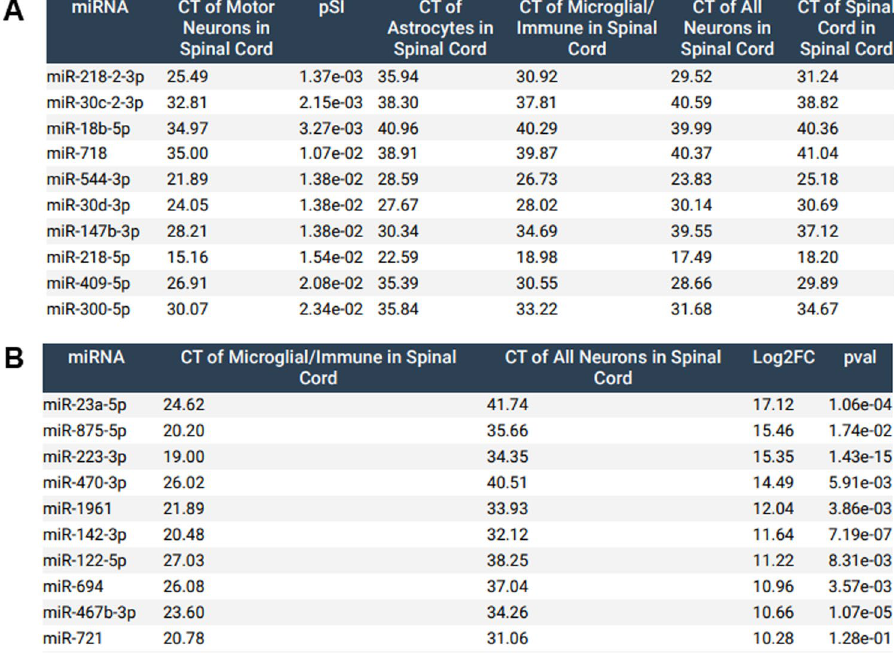
Figure 4. ( A ) Top 10 miRNAs of spinal motor neurons compared to all other cell types. miRNAs were selected and sorted by pSI value. (B) Top 10 microglial miRNAs as compared to all neurons in the spine, sorted by Log2FC.